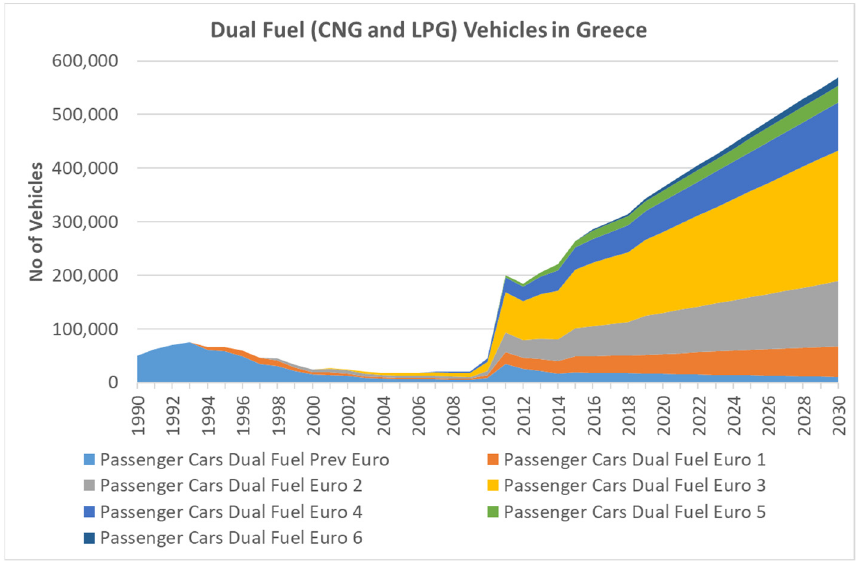
Figure 7. Time-evolution of the fleet size of dual fuel vehicles in Greece, 1990–2030.